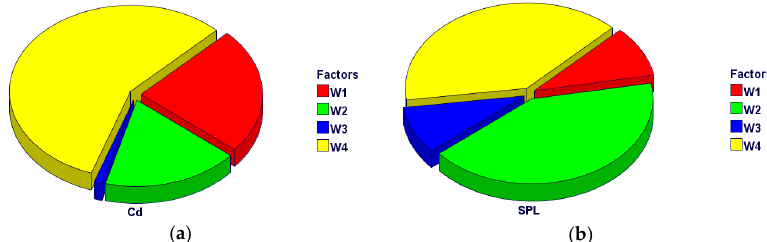
Figure 19. Student charts between the objectives and the design variables: ( a ) student chart between drag and four design variables; and ( b ) student chart between sound pressure level and four design variables.